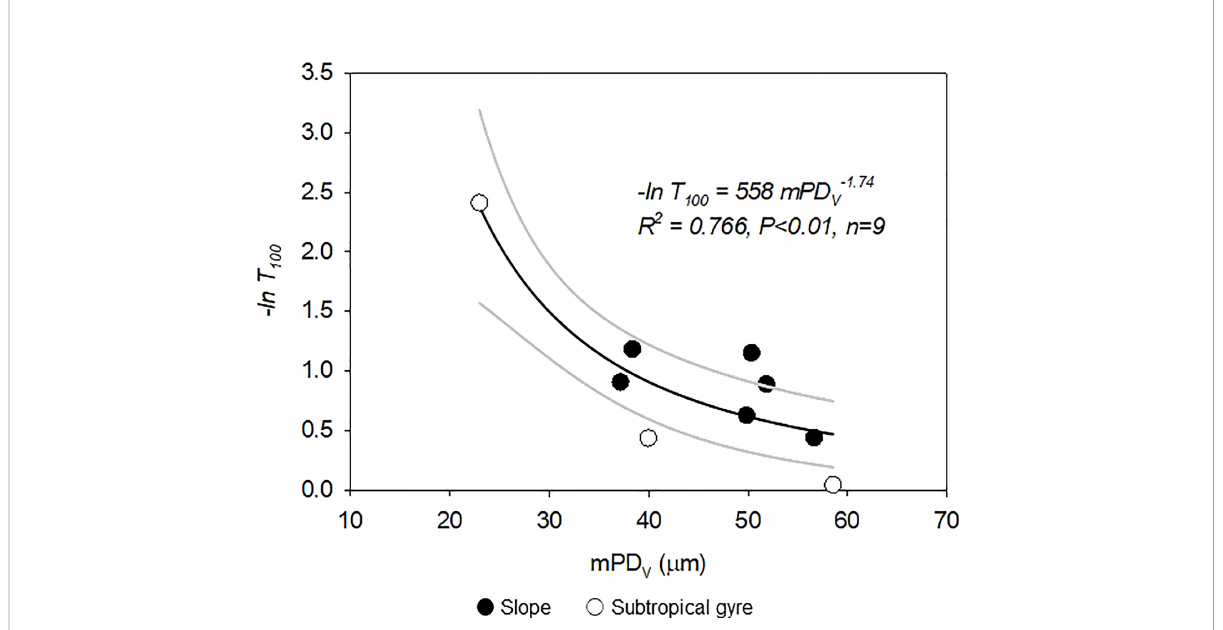
FIGURE 7 Relationship between − ln T 100 and the mean particle diameter of the volumetric particle size distribution (mPD V ). Black line indicates non-linear regression following the power-law model (Eq. 5) using the ordinary least squares method for each sampling period. Gray lines indicate the 95% con fi dence